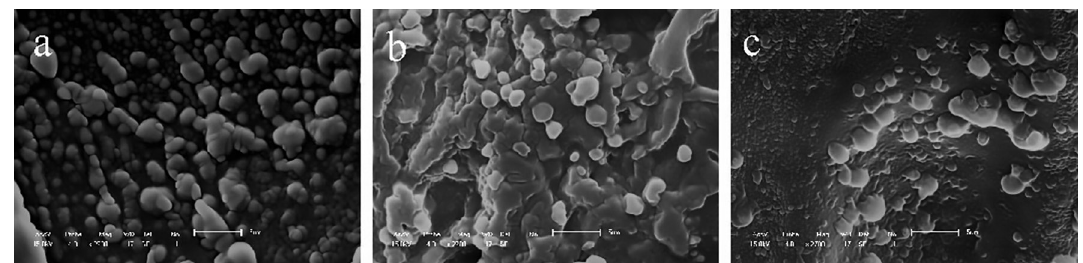
FIGURE 2 - Photomicrography obtained by scanning electron microscopy of microcapsules obtained from polymeric associations: F1-MC (a); F2-MC (b); F3-MC (c) (2700x). porous and wrinkled, a feature of the alginate polymer used (Pasparakis, Bouropoulos,